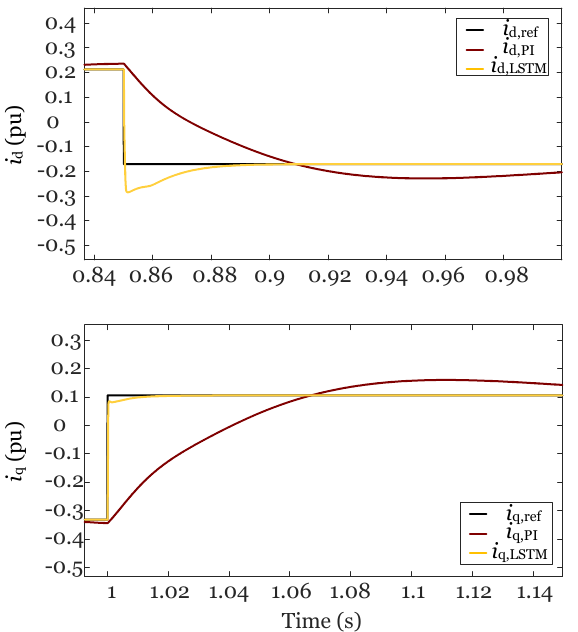
Figure 18. Controller response to 50% increase in the inductance of the grid filter. ( a ) i d , ref change; ( b ) i q , ref